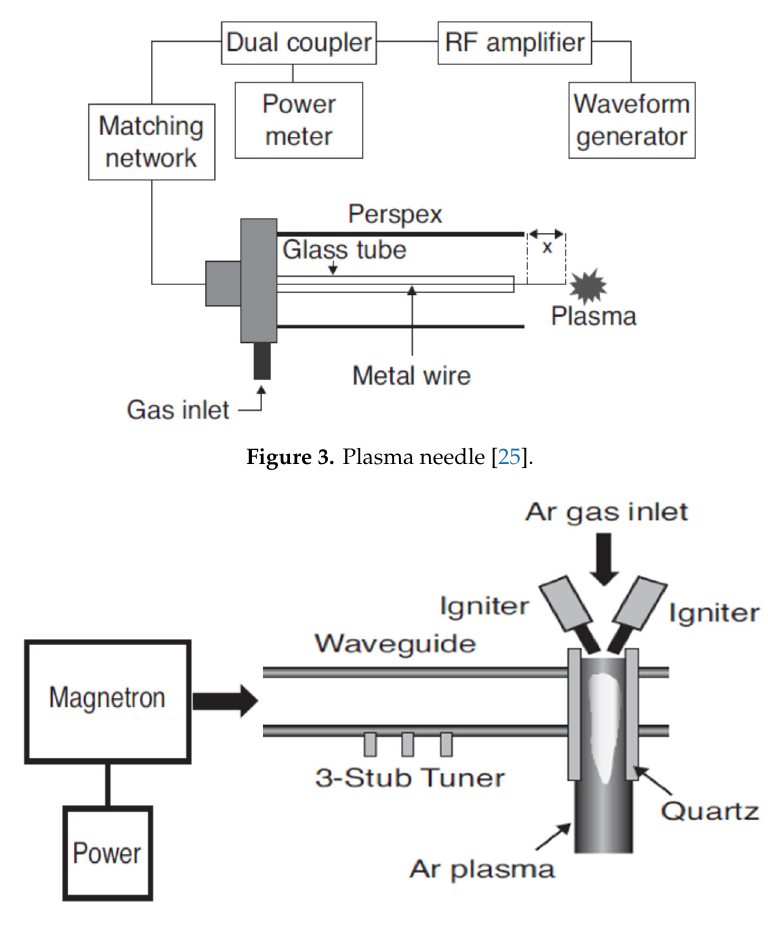
Figure 4. Microwave plasma tube [26].